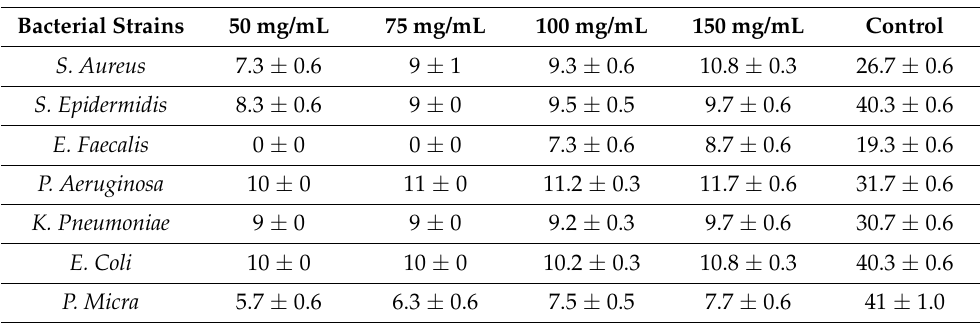
Table 1. Means ± standard deviations of inhibition zones (in mm) for different concentrations of C-CaOH 2